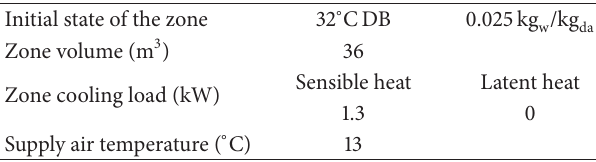
Table 1: Parameters of air-conditioned zone in